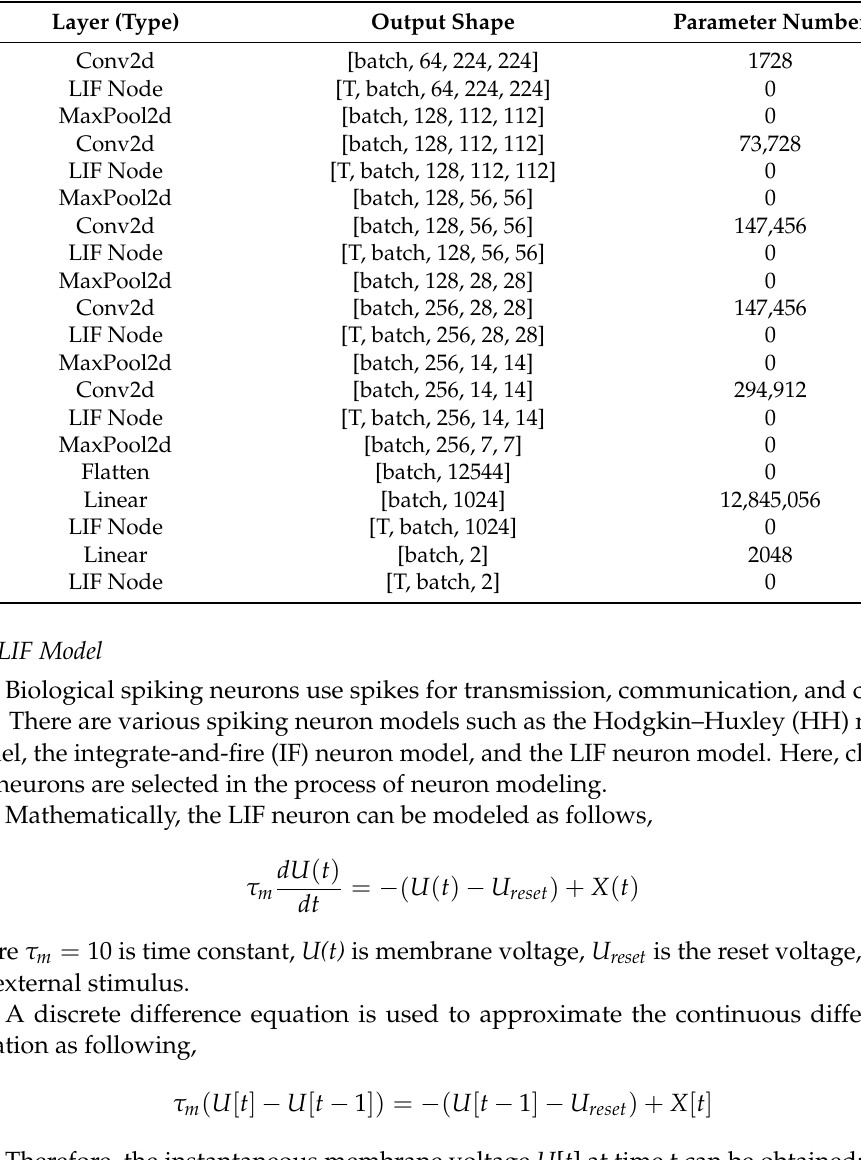
Table 1. The network parameters for the